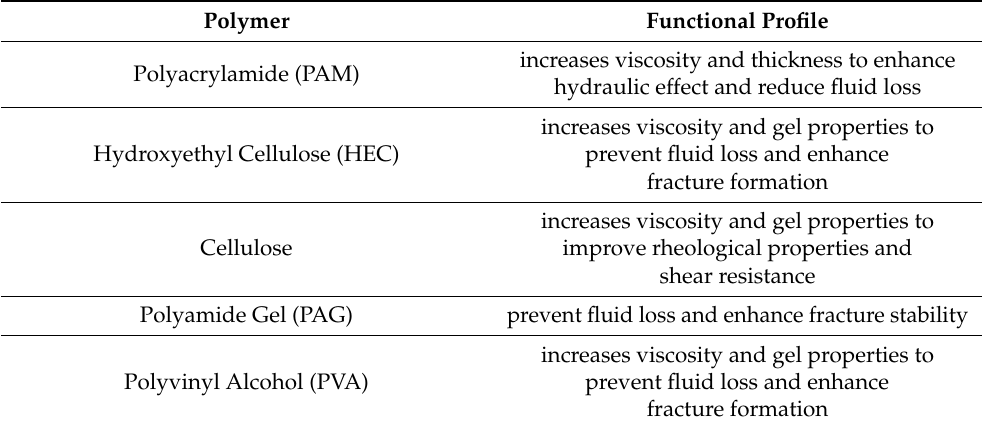
Table 1. The function profile of polymers used in water-based fracturing fluids.